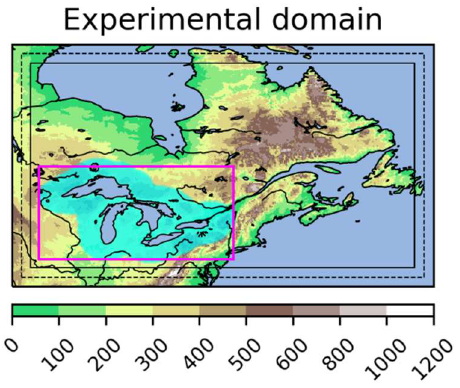
Figure 1. Experimental domain with topography (m) shown in color. The region between the inner blue solid and dashed lines is the blending zone (10 grid points wide) and the region outside the dashed rectangle is the pilot zone (10 grid points wide). The region around the Great Lakes, highlighted in cyan color, is the 200 km near-shore zone and the magenta rectangle shows the region used for analysis.